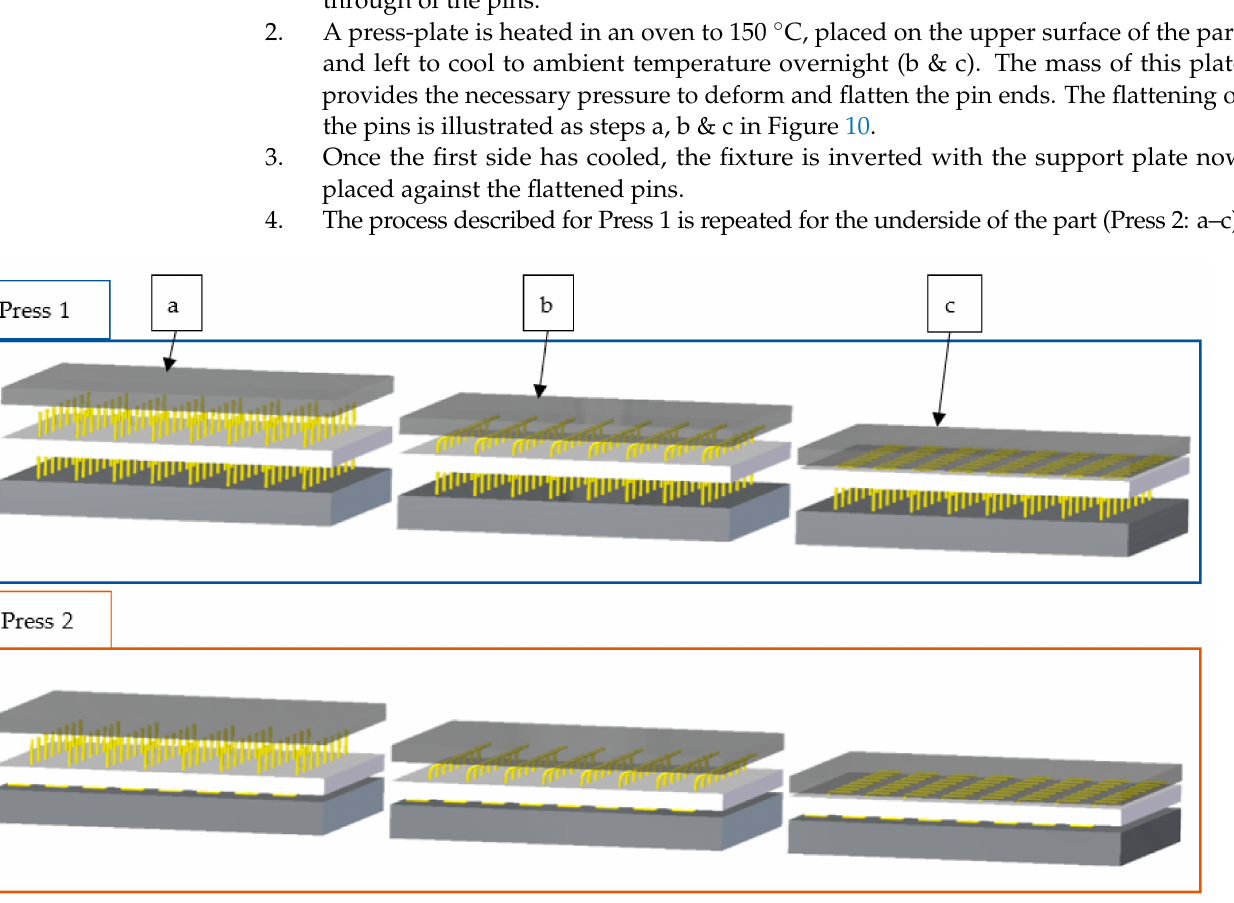
Figure 10. Graphical representation of the 2-step press